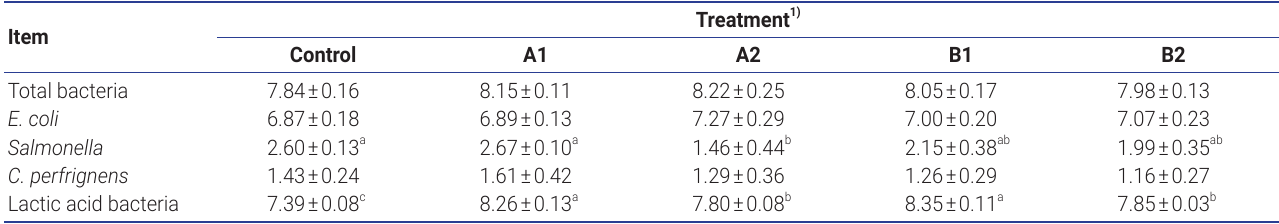
Table 4. Effects of dietary Metallo-protease and Bacillus velezensis CE 100 on intestinal microflora in broiler chickens (log10